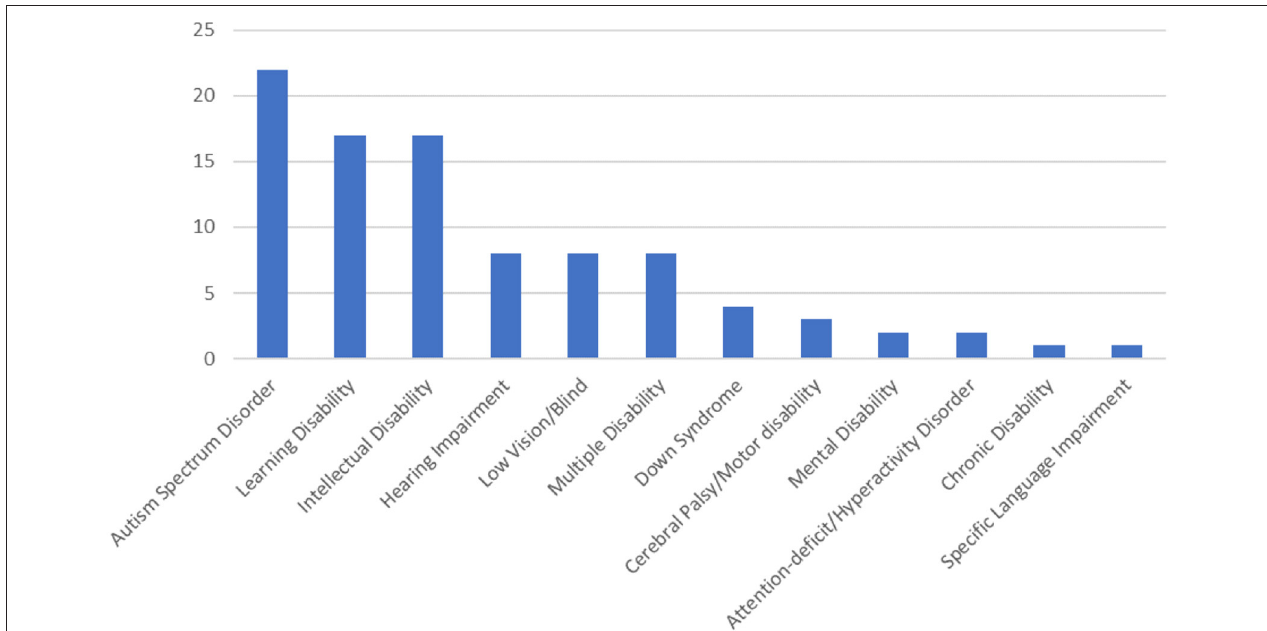
FIGURE 5 | Distribution of studies based on learners’ disabilities.